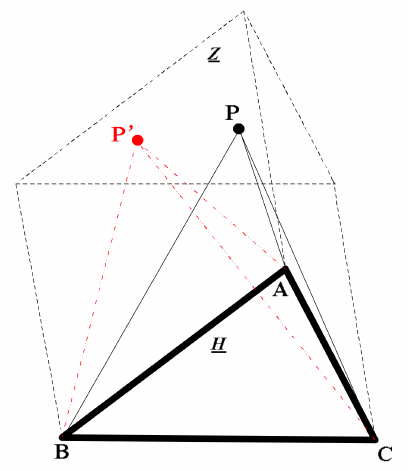
Figure 2. An example of solution uncertainty (with convex